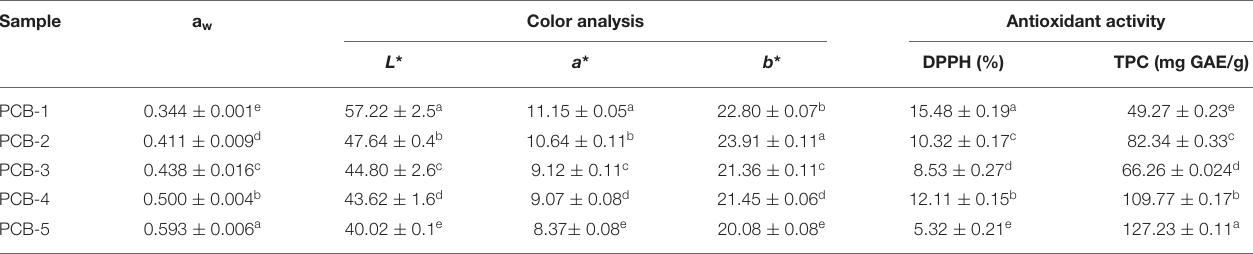
TABLE 4 | Water activity, color analysis, DPPH, and total phenolic content of pregelatinized cereal bar enriched with date paste and walnut kernels. Sample a w Color analysis Antioxidant